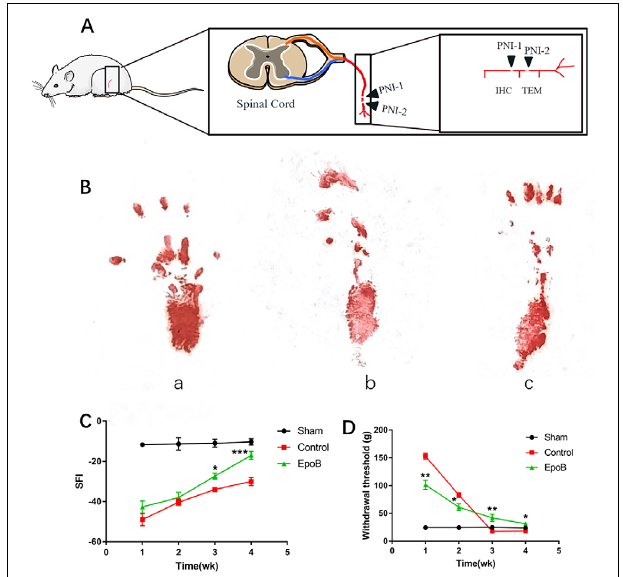
FIGURE 1 | EpoB promotes locomotor and sensory recovery after nerve injury. (A) The schematic of Peripheral nerve injurie (PNI) model in the rats. (B) Representative images of walking track prints in the sham (a), control (b), and EpoB group (c) 4 weeks postoperatively. (C) The SFI values of each group at 1, 2, 3, and 4 weeks after surgery. (D) Withdrawal threshold assesse via the von Frey hair test at the predefined time points. * P < 0.05, ** P < 0.01, and *** P < 0.001 vs. the control group. Data are presented as the mean ± SEM, n = 10 per group. Abbreviations: EpoB, epothilone B; SFI, sciatic functional